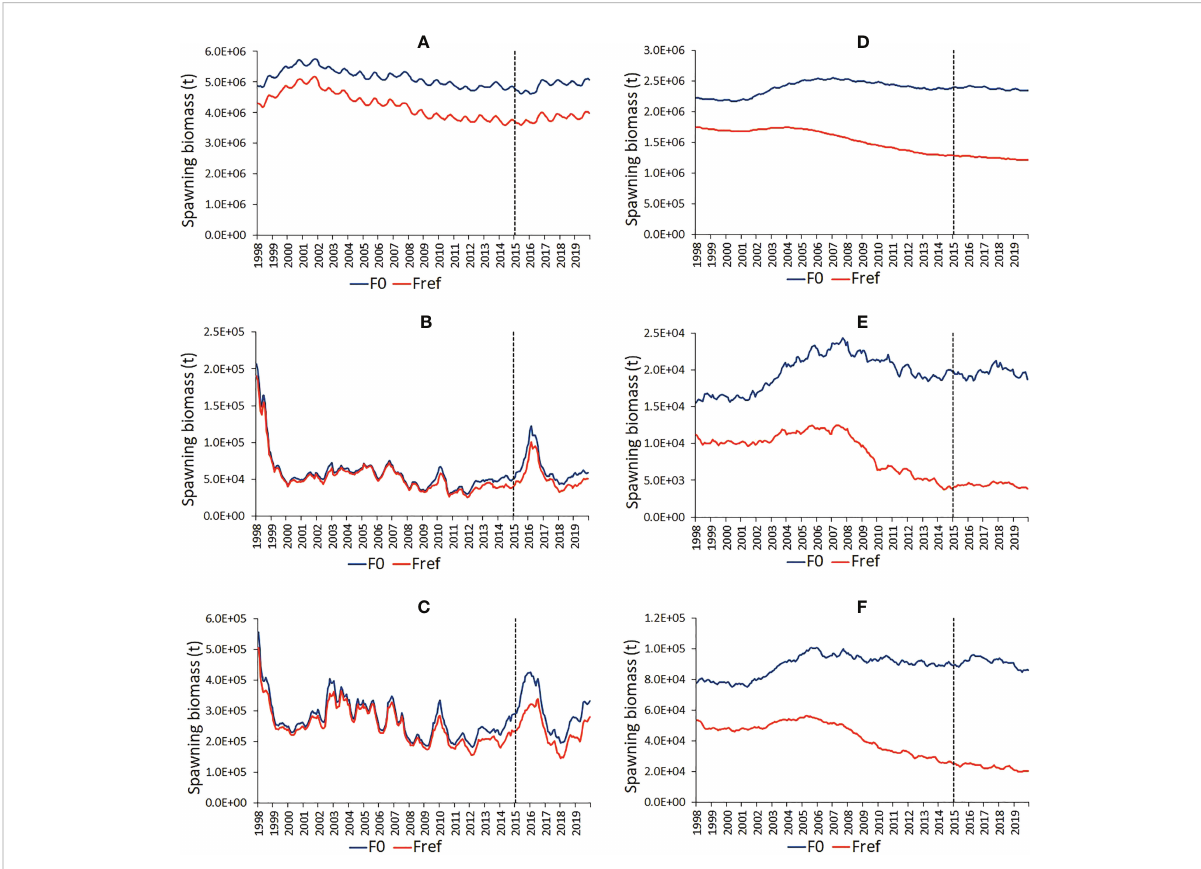
FIGURE 3 Time series of estimated skipjack (A-C) and bigeye (D-F) tuna spawning biomass under the observed fi shing activity (Fref) and in the absence of fi shing (F0) in the western and central Paci fi c Ocean (A, D) , in the PIPA ( B , E ) and in the PIPA fi ve-degree spill-over area (C, F) . The vertical dashed lines indicate the implementation of the PIPA